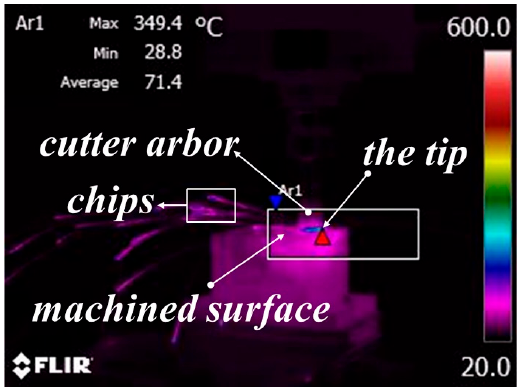
Figure 6. Infrared thermal image of the high-speed milling experiment.